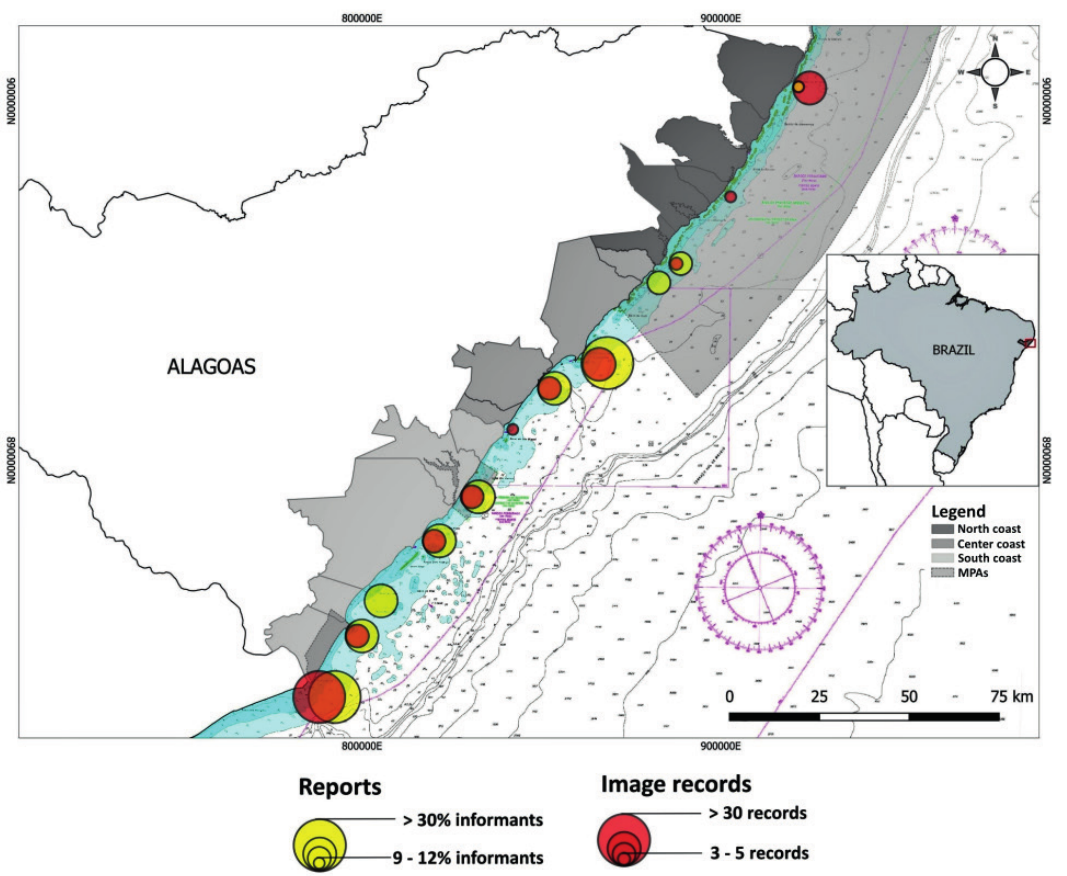
FIGURE 1 | Distribution of Atlantic Goliath Grouper (AGG) Epinephelus itajara from the coast of Alagoas. Sites with the occurrence of the AGG validated through photographic or scientific records (Image records); places cited by informants for the occurrence of the species (Reports). Alagoas State, Brazil. The Alagoas coast was separated into north, central and south sectors. The figure highlighted Federal Marine Protected Areas (MPA), on the north coast is the MPA “Costa dos Corais”. To the south is located the Marine Extractive Reserve of Lagoa do Jequiá and Environmental Protection Area of Piaçabuçu in the extreme south of the